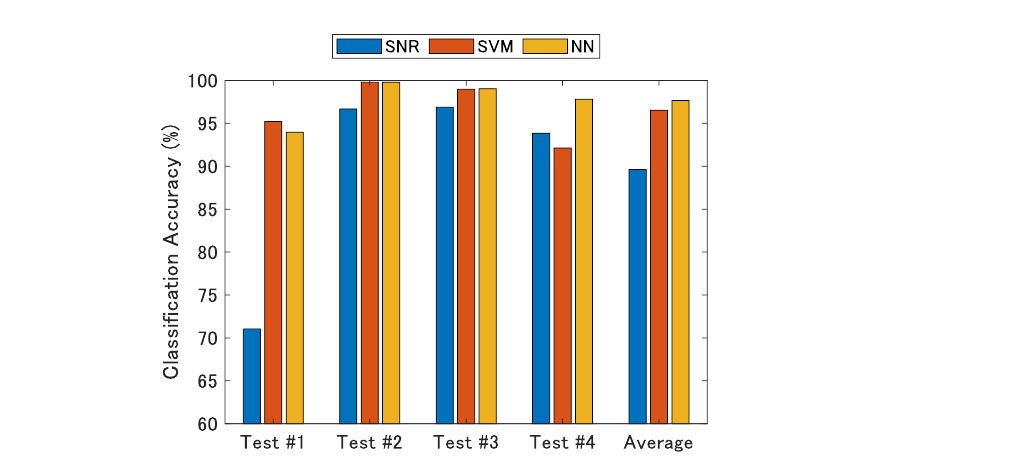
Figure 14. Classification accuracy using SNR, SVM, and NN. NN has the best performance among the three proposed classifiers.